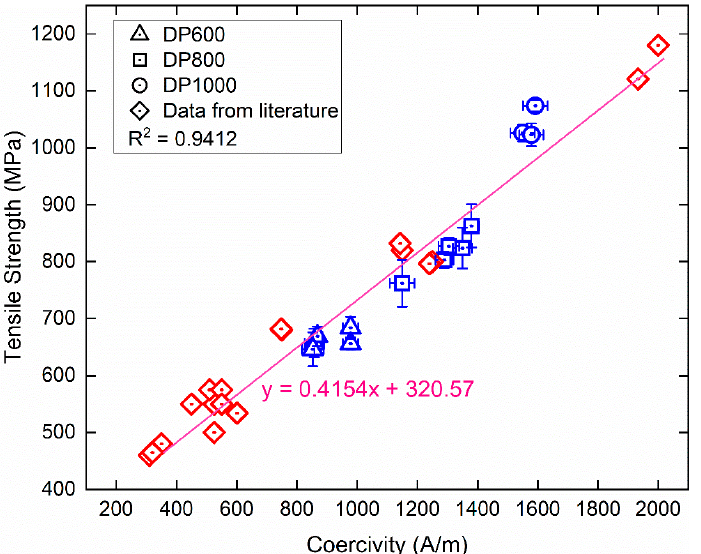
Figure 5. Tensile strength versus coercivity for the commercial DP600, DP800 and DP1000 steel samples, compared to a set of high-strength construction steel [12] and laboratory heat-treated DP steel [22].